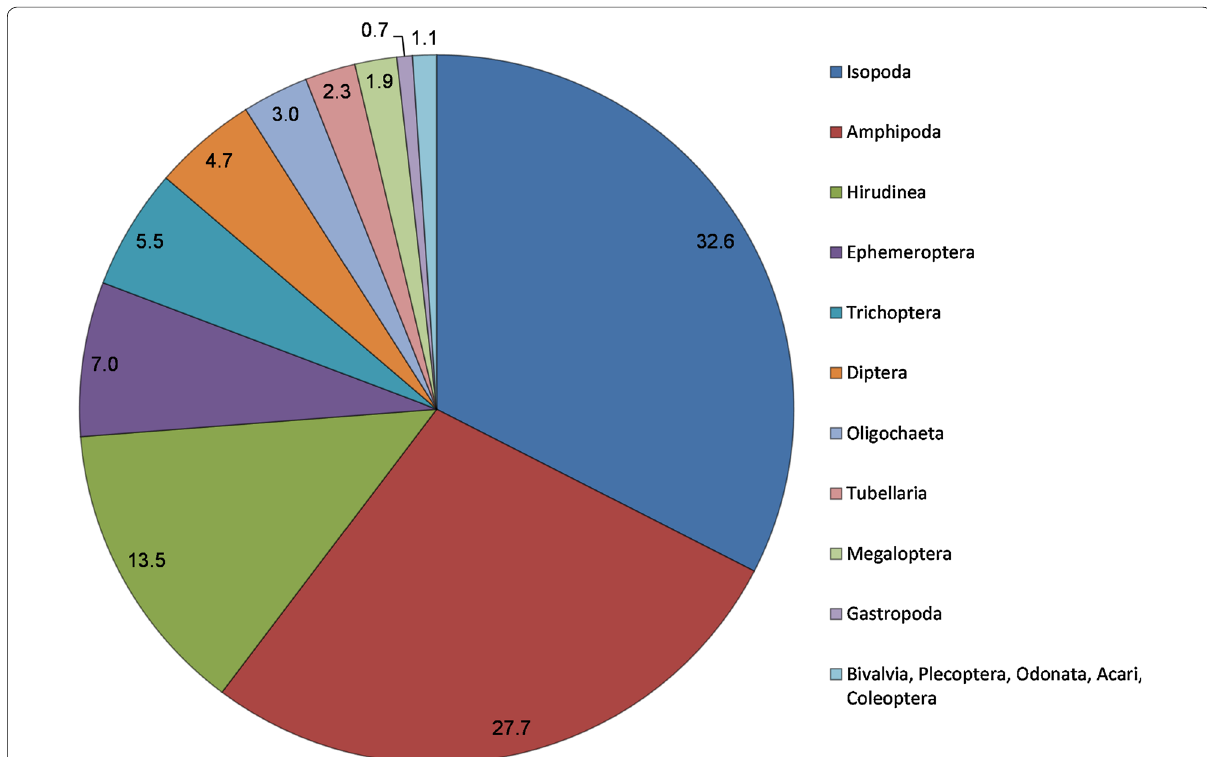
Fig. 3 Percentage composition of macroinvertebrate community of all eight stream mesocosms on pre‑sampling days stream mesocosms during the study